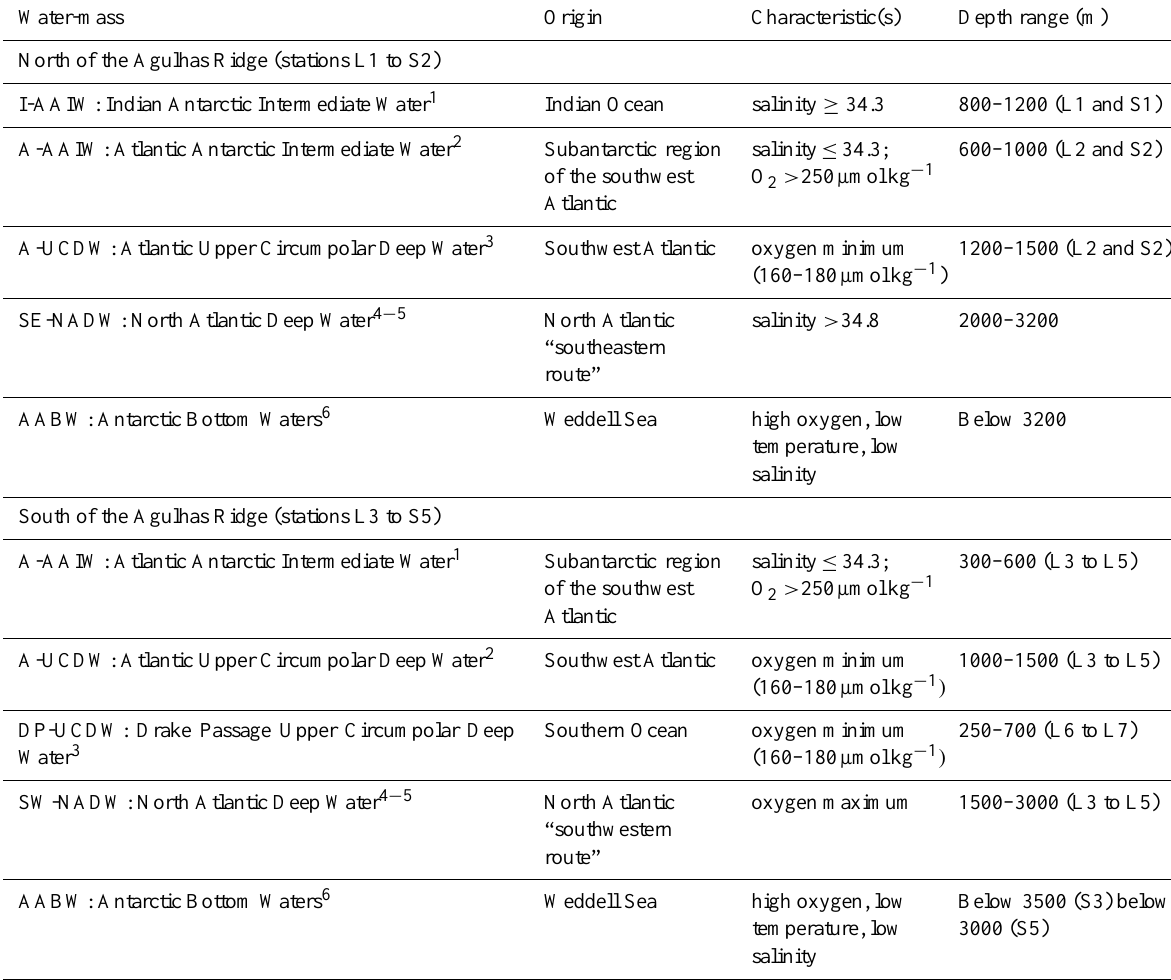
Table 2. Water-masses origins, characteristics and depth ranges along the BONUS-GoodHope